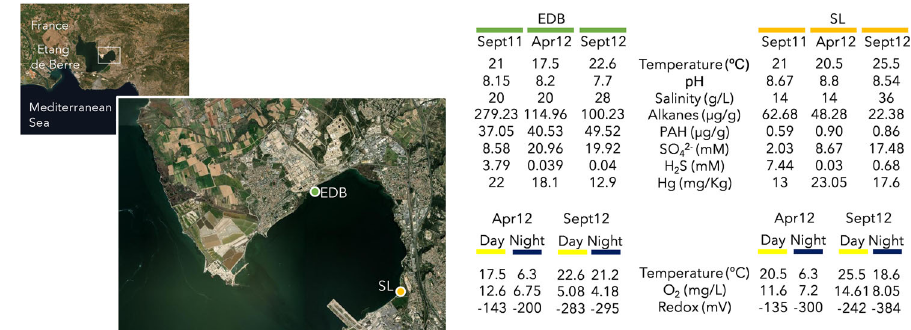
Fig. 1 Description of the study sites. EDB and SL microbial mats, separated by 5 km, are both localized in the Etang de Berre area, South of France. EDB mat was collected near an oil industry wastewater discharge whereas SL mat was sampled in the Salins du Lion bird reserve. Chemical and physical parameters of the microbial mats during the sampling events. Alkanes include C11 to C38. PAH polycyclic aromatic hydrocarbons. Additional and more detailed dataset is available in Aubé et al. (2016, 2020) 15,19